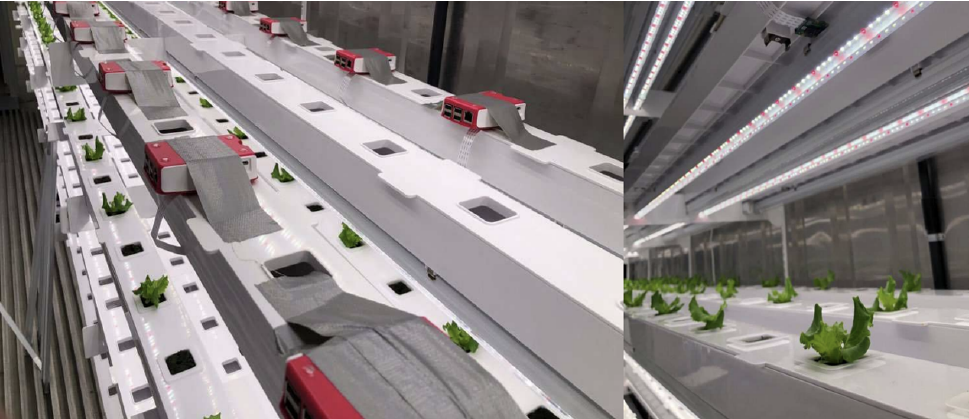
Figure 3. Example of a vertical farms environment. Monitoring images are collected from the vertical top of the crop, as shown in the